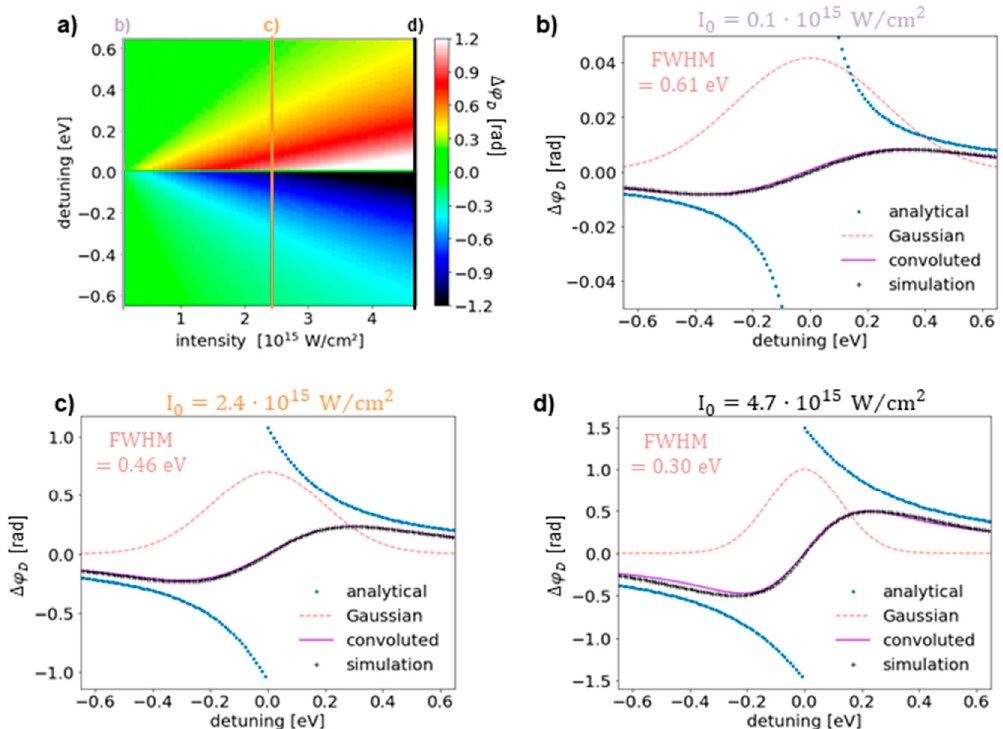
Figure 3. ( a ) dipole phase shifts ∆φ (cid:2888) calculated analytically with Equation (11). A jump from positive to negative dipole phase shifts at zero detuning is clearly present as well as the monotonic increase (decrease) of ∆φ (cid:2888) for blue (red) detuned pulses. ( b – d ) lineouts of the dipole phase shift (of Figure 3a), blue) are convoluted along the detuning axis (violet) with an intensity-dependent Gaussian profile (depicted at the resonance position, red) and compared to the numerical results (Figure 2d), black). ( b ) for the lowest intensity, I (cid:2868) = 0.1 · 10 (cid:2869)(cid:2873) W/cm (cid:2870) , the Gaussian convolution function with a FWHM = 0.61 eV corresponds to the spectrum of the 3 fs Gaussian driving pulse. ( c , d ) for higher intensities, I (cid:2868) = 2.4 · 10 (cid:2869)(cid:2873) W/cm (cid:2870) and I (cid:2868) = 4.7 · 10 (cid:2869)(cid:2873) W/cm (cid:2870) , respectively, a decreasing FWHM of